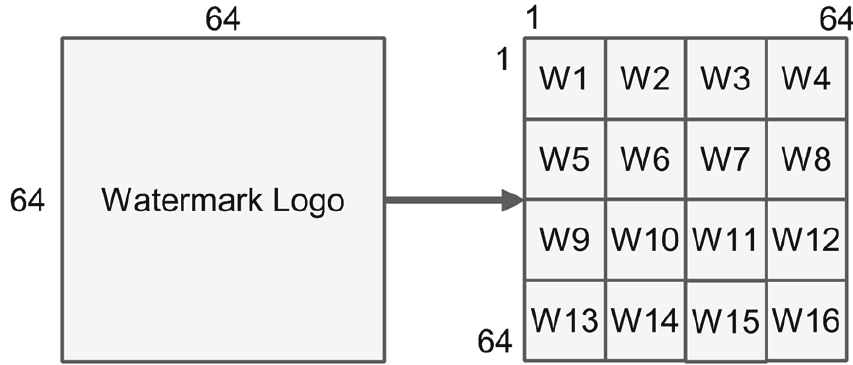
Figure 3: Watermark division.